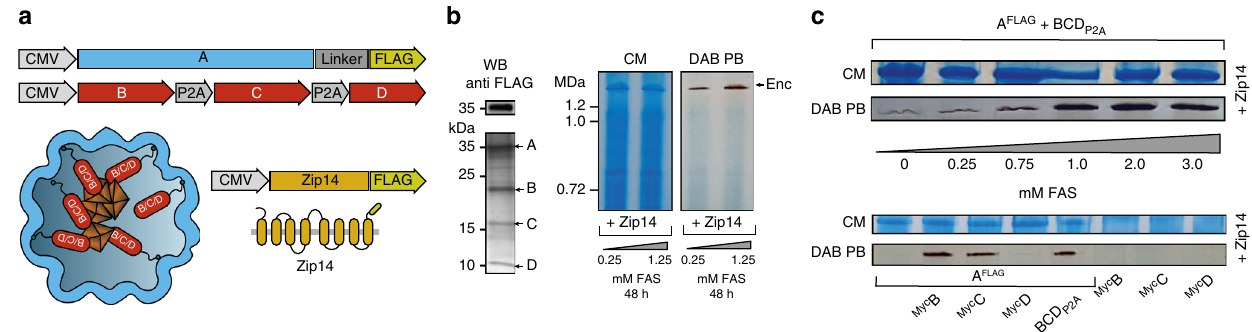
Fig. 6 Ef fi cient iron loading of eukaryotically expressed encapsulin nanospheres a Schematic of a dual-promoter construct used for generation of a stable cell line expressing A FLAG and all native cargos B, C, and D. Also depicted is a construct encoding the iron-transporter MmZip14 FLAG (Zip14) used to transport additional amounts of iron into the cell. b Co-immunoprecipitation (Co-IP) against the FLAG epitope from a whole cell lysate of a stable HEK293T clone expressing A FLAG together with B, C, and D analyzed by silver-stained SDS PAGE and the corresponding WB against the FLAG epitope (left panel). The pair of Blue Native (BN) gels visualizes proteins from whole cell lysates via Coomassie staining (CM) (left panel) and iron content via treatment with DAB enhanced Prussian Blue (DAB PB) (right panel) from the same stable cell line. Robust iron loading of the assembled nanocompartments was achieved by transient co-expression of MmZip14 FLAG - IRES -ZsGreen1 in which case 0.25 mM ferrous ammonium sulfate (FAS) for 48 h was suf fi cient to see strong iron loading. c BN gel stained with CM or DAB PB loaded with whole cell lysates of HEK293T cells transiently expressing A FLAG + BCD P2A and Zip14 FLAG supplemented with different concentrations of FAS (0 – 3 mM) for 48 h (upper panel). The strong bands, which correspond to the assembled nanoshell, indicate high expression levels of encapsulins and ef fi cient, dose-dependent iron loading. The lower panel shows a CM and DAB PB-stained BN gel from whole cell lysates of HEK293T cells expressing Zip14 FLAG and different combinations of native cargo molecules: Myc B, Myc C, and Myc D alone, or all three (BCD P2A ) with or without A FLAG . The robust DAB PB stains show that the ferritin-like cargo proteins B or C are suf fi cient for iron loading into encapsulins. FAS was supplemented at 2.5 mM for 48 h